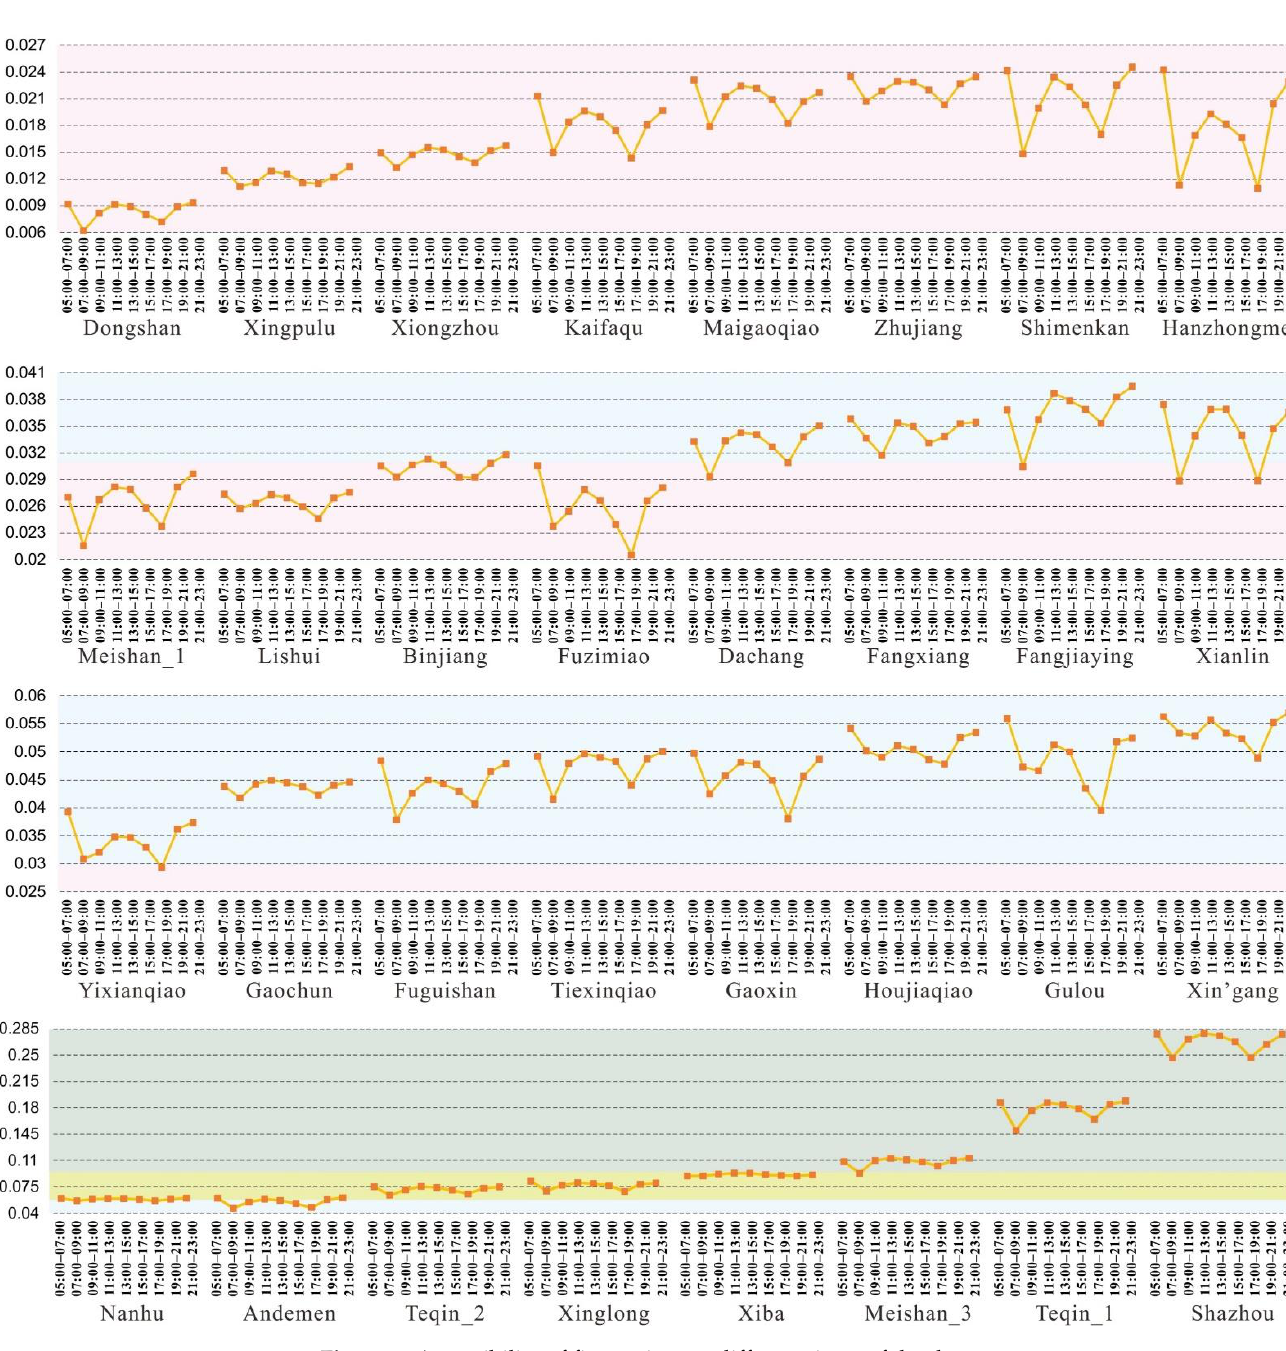
Figure 6. Accessibility of fire stations at different times of the